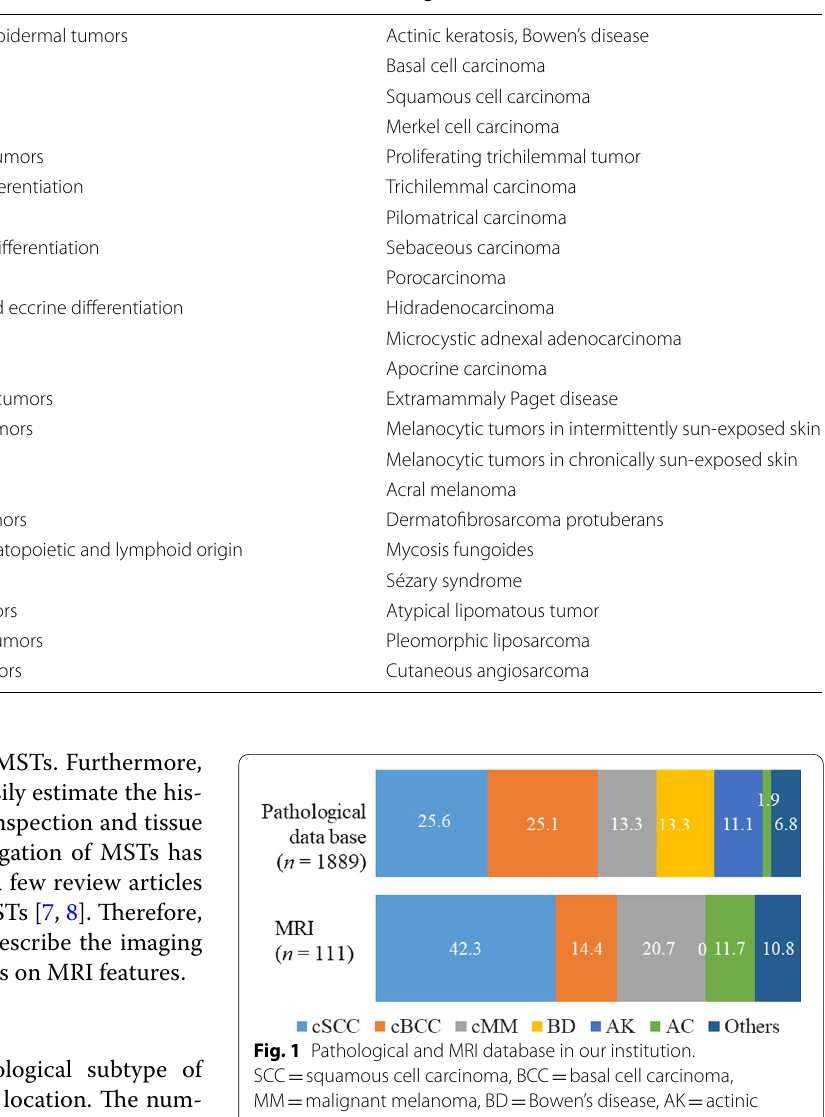
Table 1 Classification of malignant skin tumors Layer